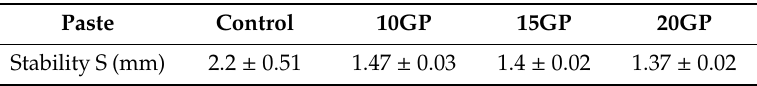
Table 4. Stability of CEM I and GD